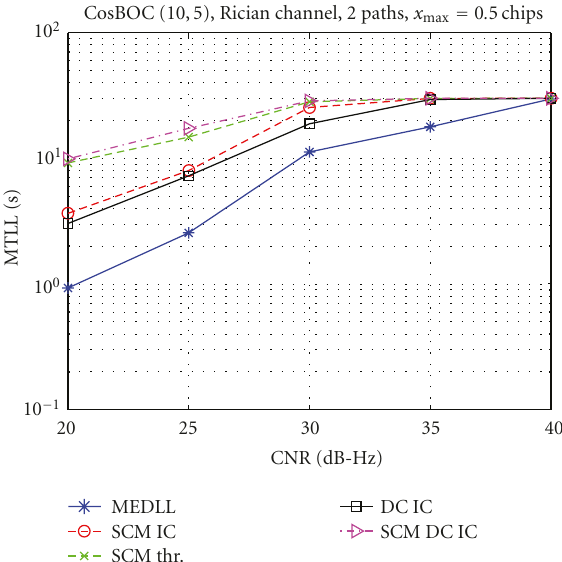
Figure 25: Comparison of feedforward delays estimation algo- rithms employing the MEDLL and IC methods and of the SCM with threshold approach, as a function of CNR; CosBOC(10,5) modula- tion, 2-paths decaying PDP Rician channel, v = 45 km/h, x max = 0 . 5